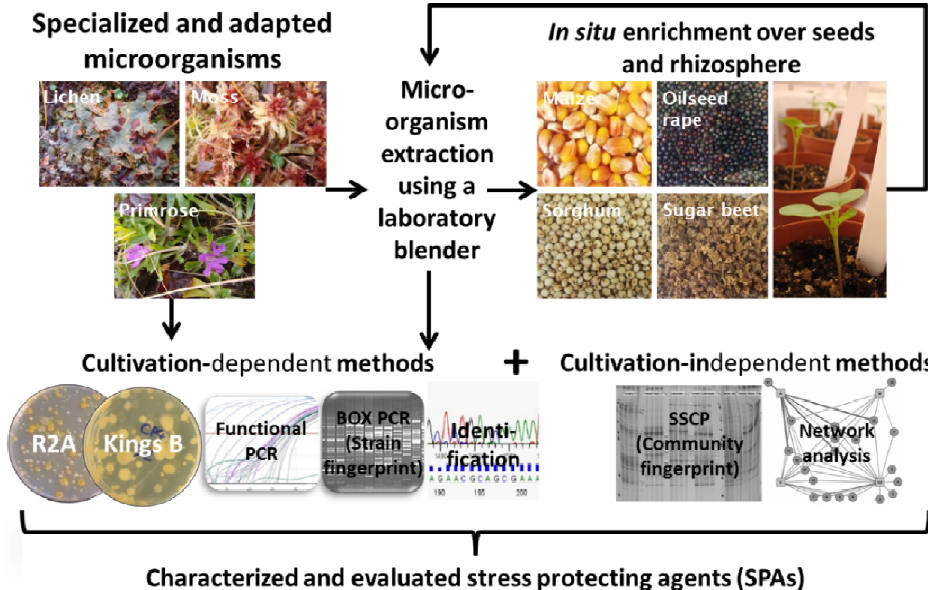
Figure 1. Selection strategy. Abbreviations: R2A, minimal medium to isolate universal bacteria; SSCP, single strand conformation polymorphisms